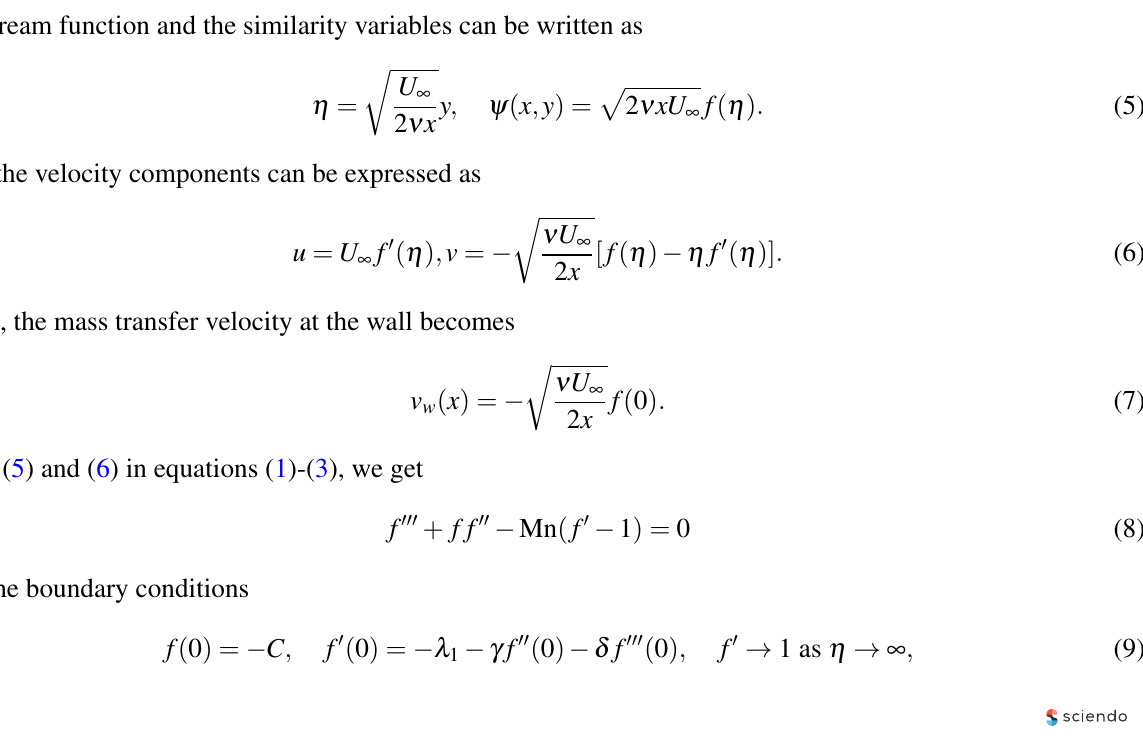
Fig. 1 Physical model with coordinate system. δ 1 represents the thickness of the boundary